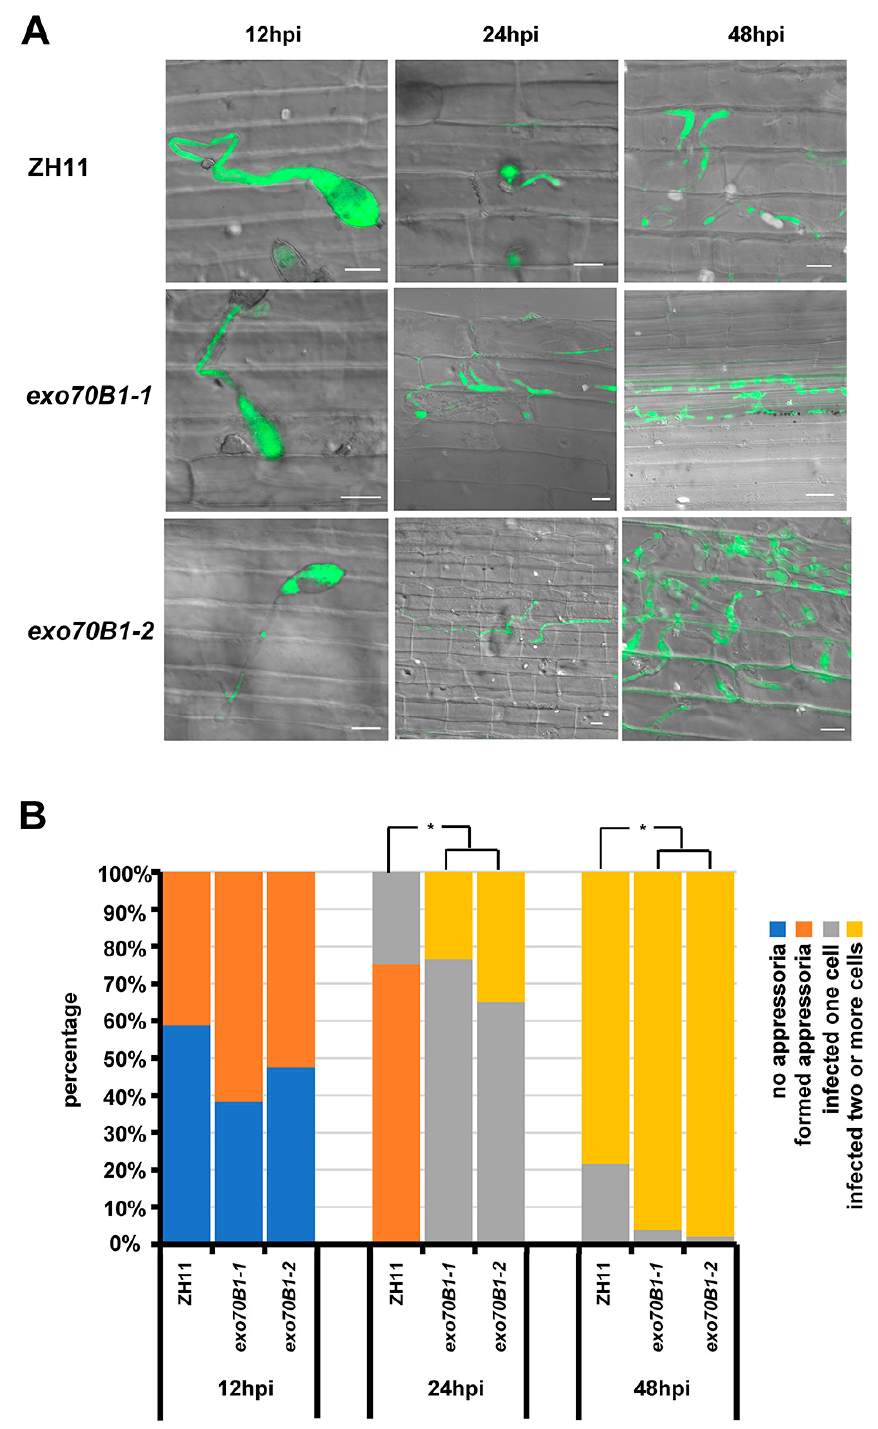
Figure 6. The infection progress of the enhanced green fluorescent protein (eGFP)-tagged M. oryzae isolate Zhong1 in exo70B1-1 , exo70B1-2 and ZH11 leaf sheath cells at different time periods after inoculation. ( A ) Representative laser scanning microscopy images of ZH11, exo70B1-1 and exo70B1-2 leaf sheath cells infected by the eGFP-tagged M. oryzae isolate Zhong1. Bar = 10 μ m. ( B ) Distribution of fungal infection progression at 12, 24, and 48 hpi. At least 30 single-cell interaction sites were examined per replication. Each bar represents the mean of three replications. Asterisks represent significant di ff erences (* p < 0.05, Student’s t